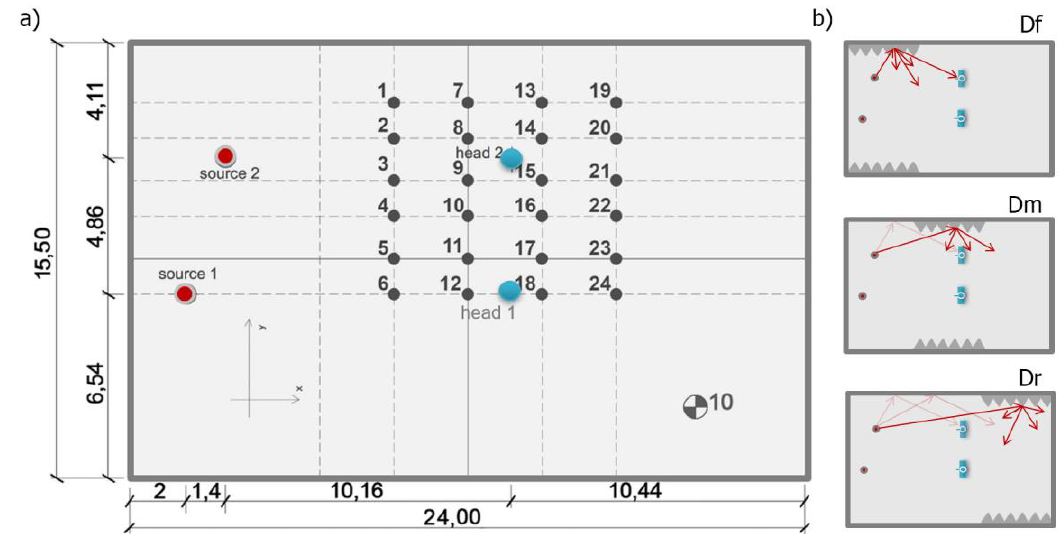
Figure 2. ( a ) Measurement positions (source, microphones, and artificial head) and main dimensions of the room (metric scale). ( b ) Schematic plan view of the diffusers location with respect to the source and artificial head positions.